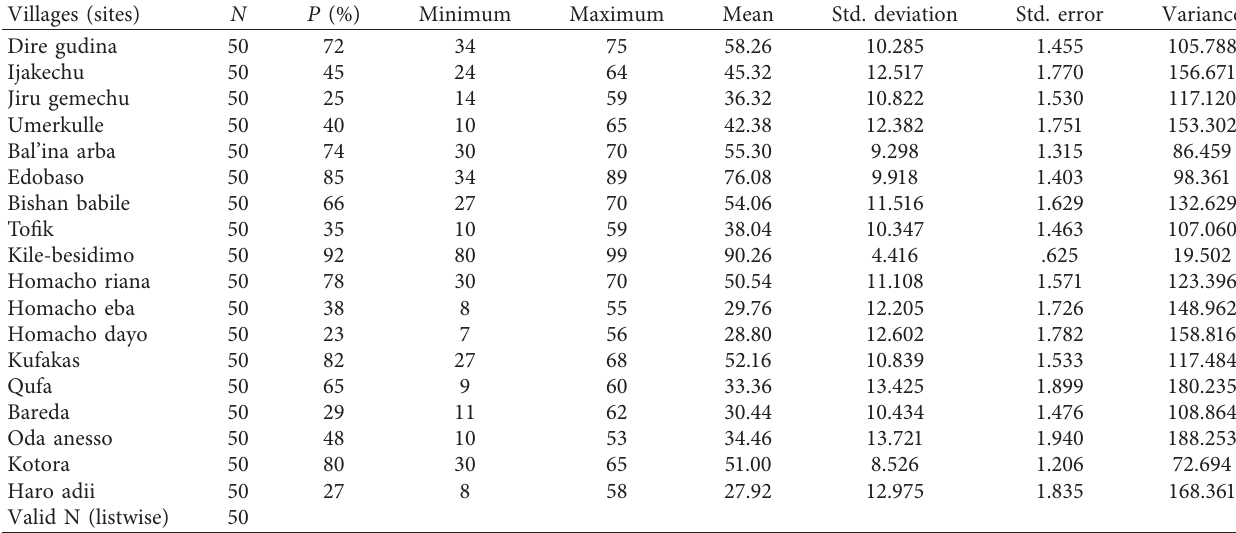
Table 3: Striga hermonthica infestation per meter square in six districts of the east and west Hararghe Zone 2019 cropping seasons. Villages (sites) N